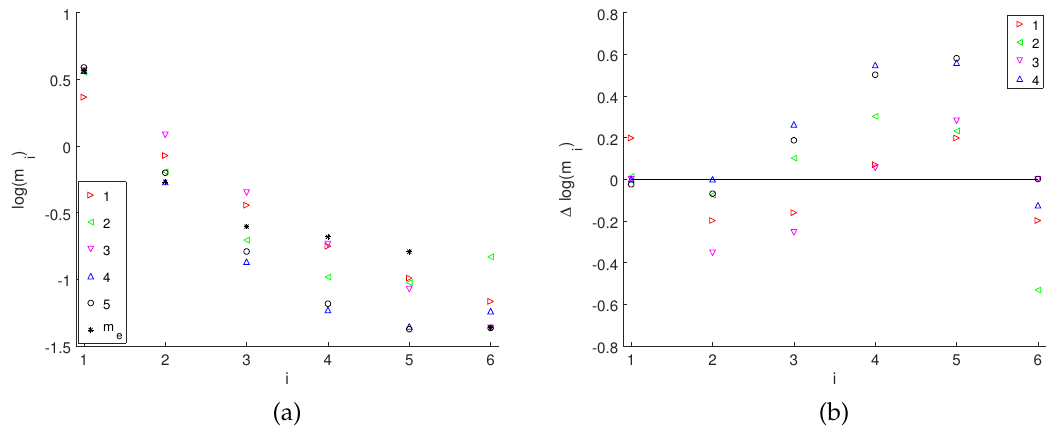
Figure 9. ( a ) theoretical values of the logarithms m i (asterisk * marks measured values) describing average values of 35-mm pipes; ( b ) deviations of theoretical logarithms of the values of m i from logarithms of the values m e obtained experimentally, i = 1, ..., 6 for criteria i